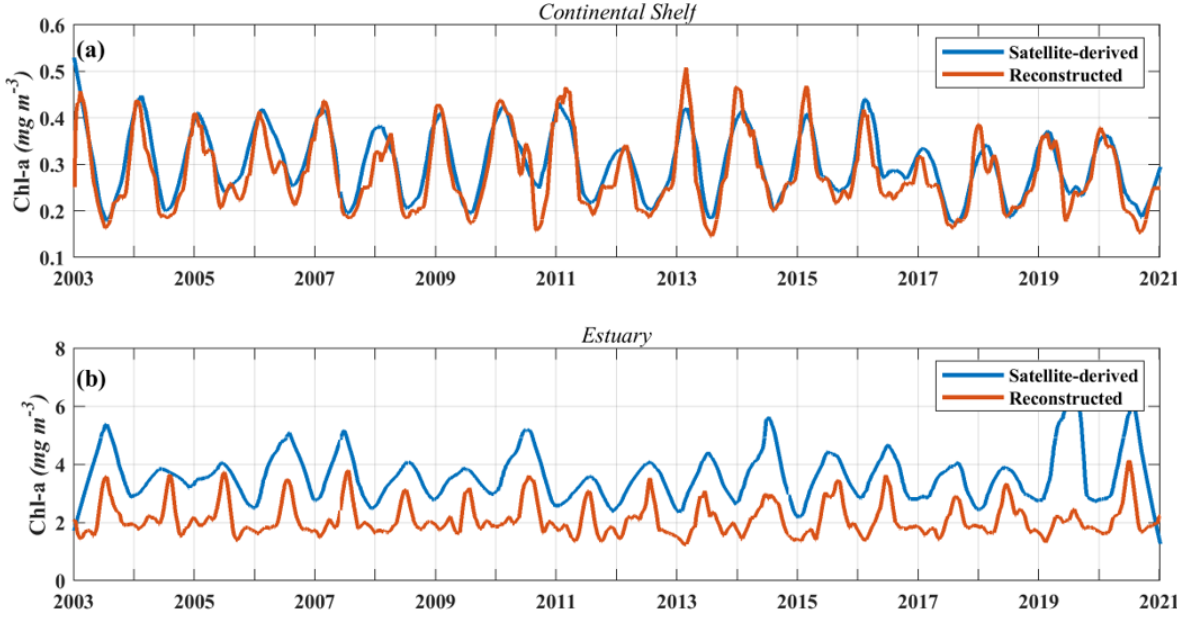
Figure 9. Time series of daily mean of satellite−derived and reconstructed C chla in the continental shelf ( a ) and estuary ( b ).